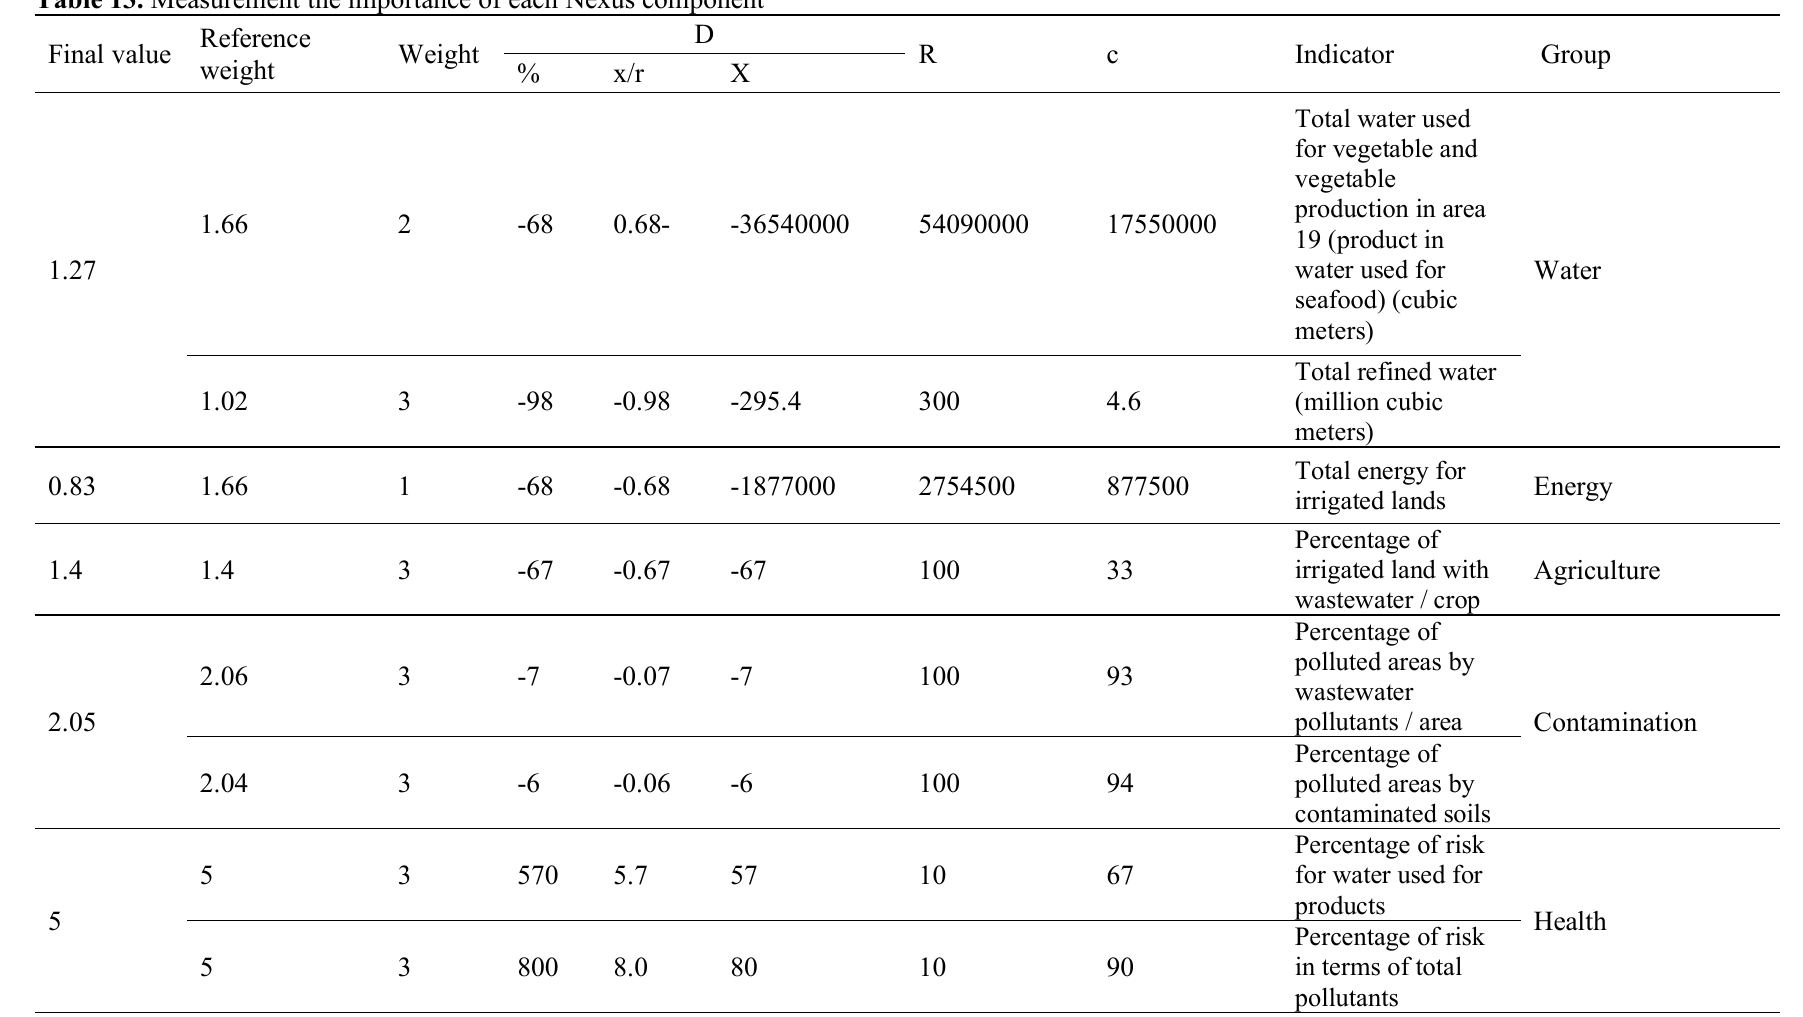
Table 13. Measurement the importance of each Nexus